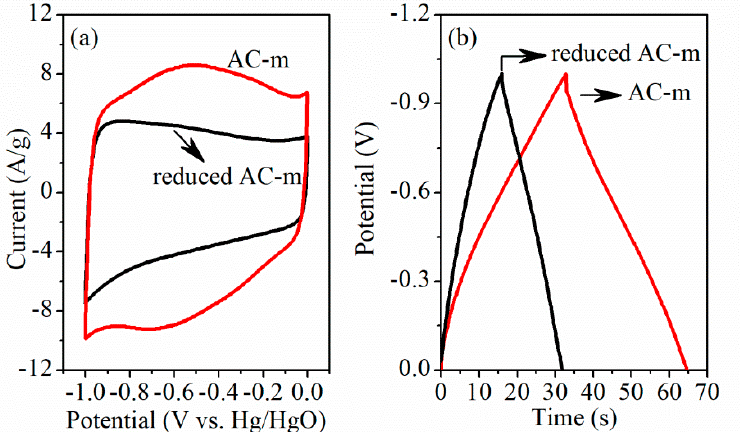
Figure 12. XPS C1s spectra of AC-m sample before ( a ) and after ( b ) reduced thermal treatment in 4% H 2 and 96% Ar at 900 °C for 3 h.